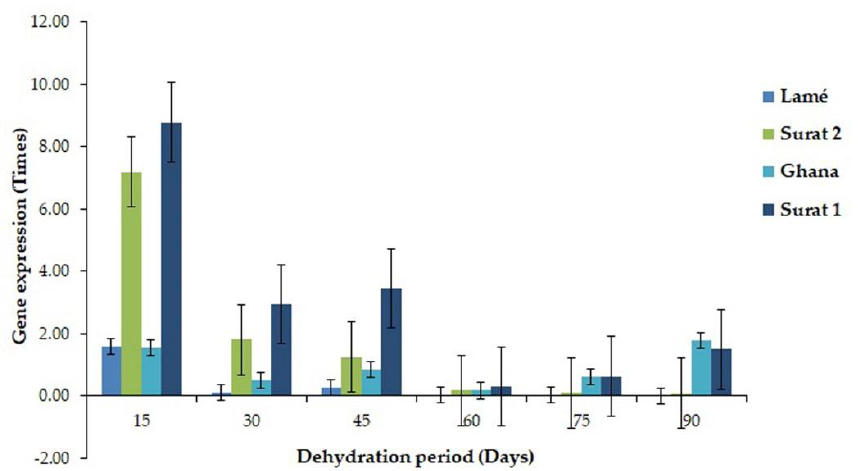
Figure 7. Gene expression value of Cys gene (cysteine proteases, Cys ) in different oil palm root varieties at different water deficit Figure 7 . Gene expression value of Cys gene ( cysteine proteases, Cys ) in different oil palm root vari- eties at different water deficit periods .